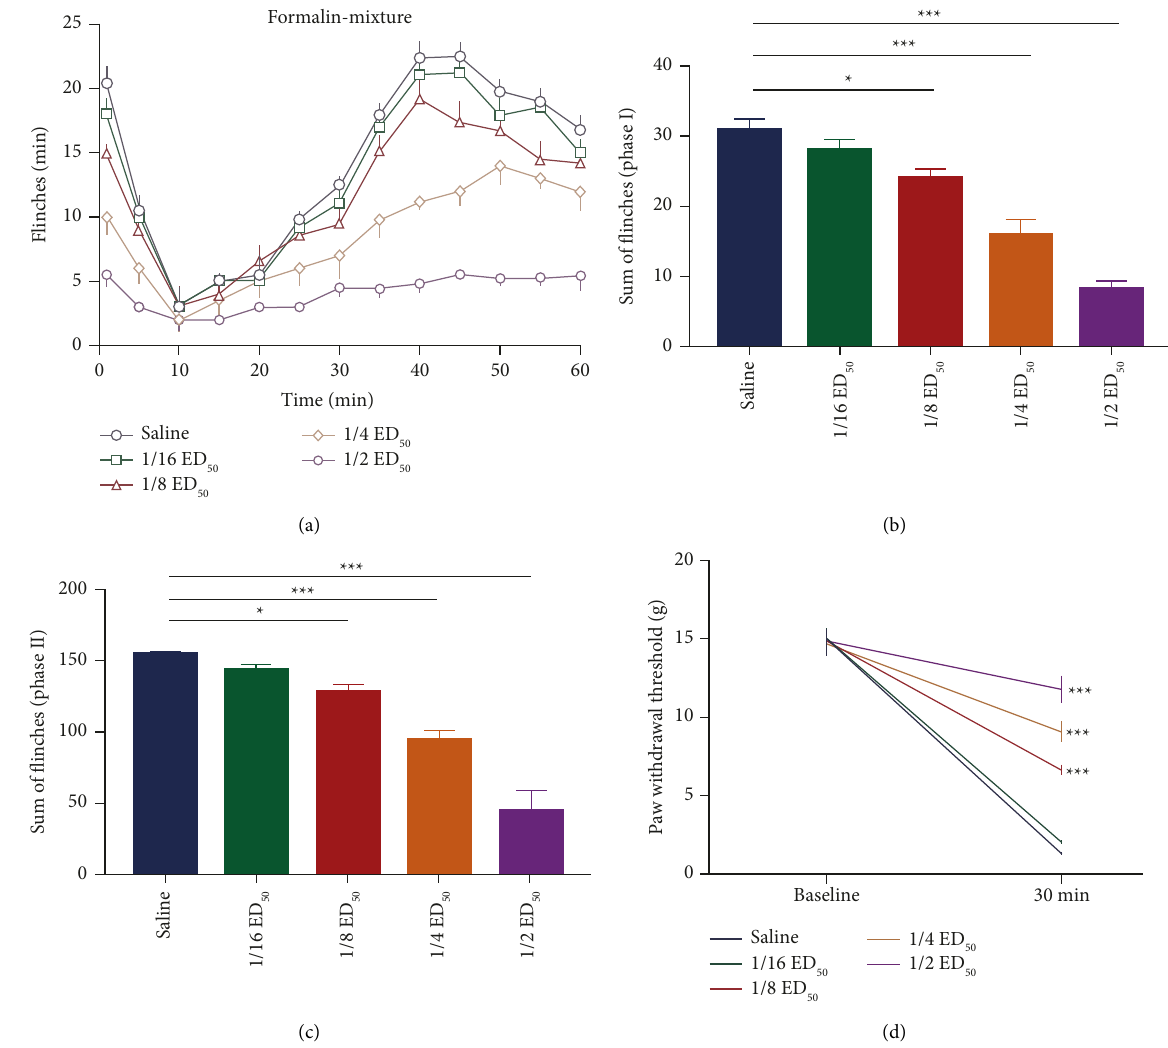
Figure 3: (a-c). Intrathecal administration of the pentazocine-neostigmine mixtures attenuated the number of paw flinches in the formalin pain model. (d). Intrathecal administration of the pentazocine-neostigmine mixtures attenuated the mechanical allodynia in the plantar incision pain model. Each bar represents the mean ± SEM from 10 rats. Compared with the saline group, ∗ P < 0 . 05, ∗∗ P < 0 . 01, ∗∗∗ P < 0 . 001, n � 10 rats in each